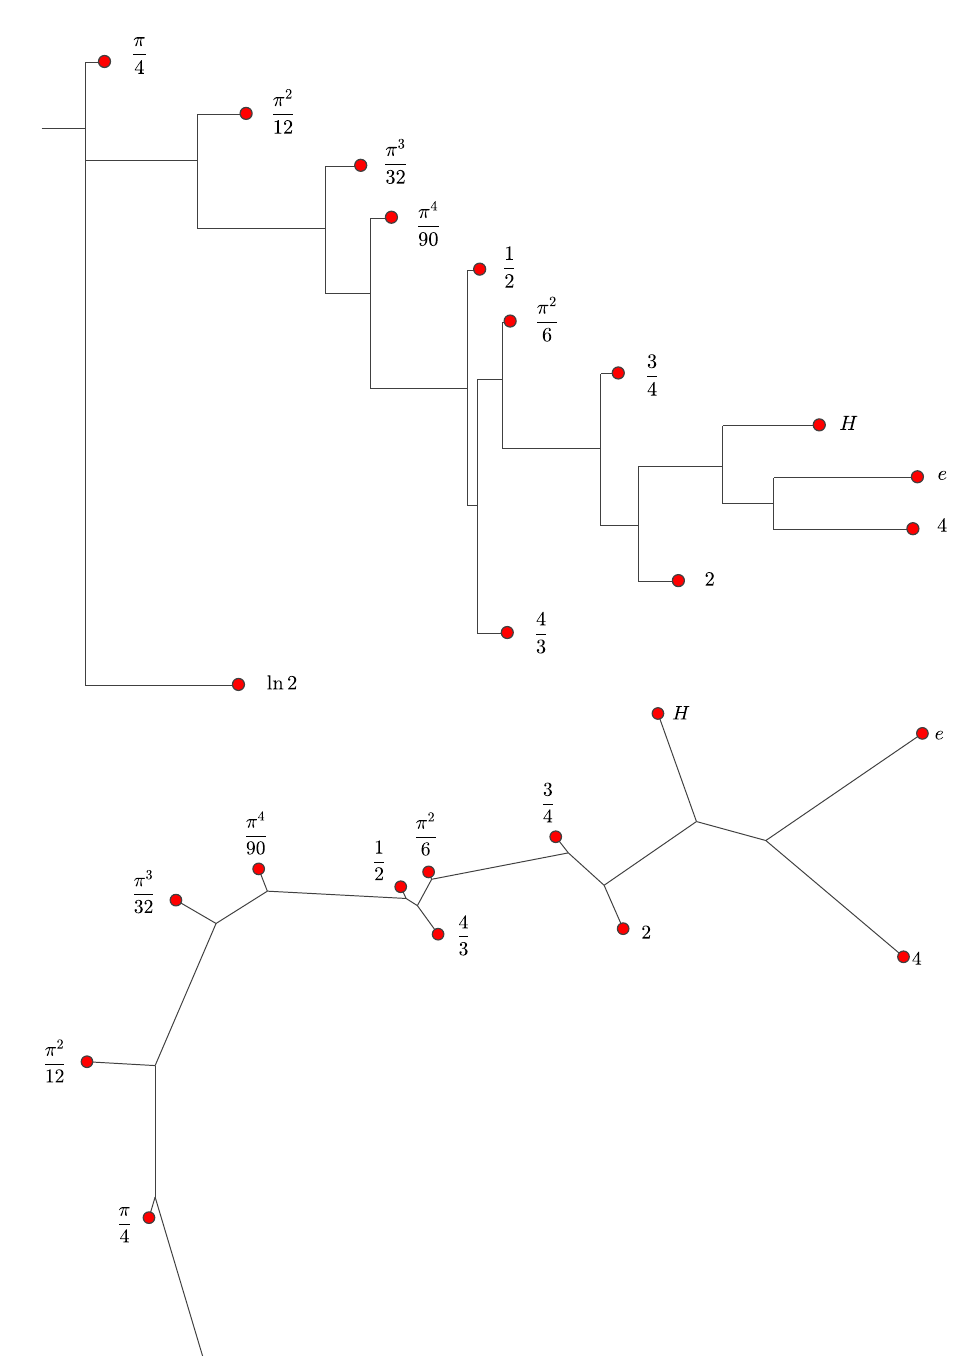
Figure 1. Dendrogram ( top ) and tree ( bottom ) representations of the numerical series S i , i = 1, . . . ,13, produced by the ArcCosine distance for r =